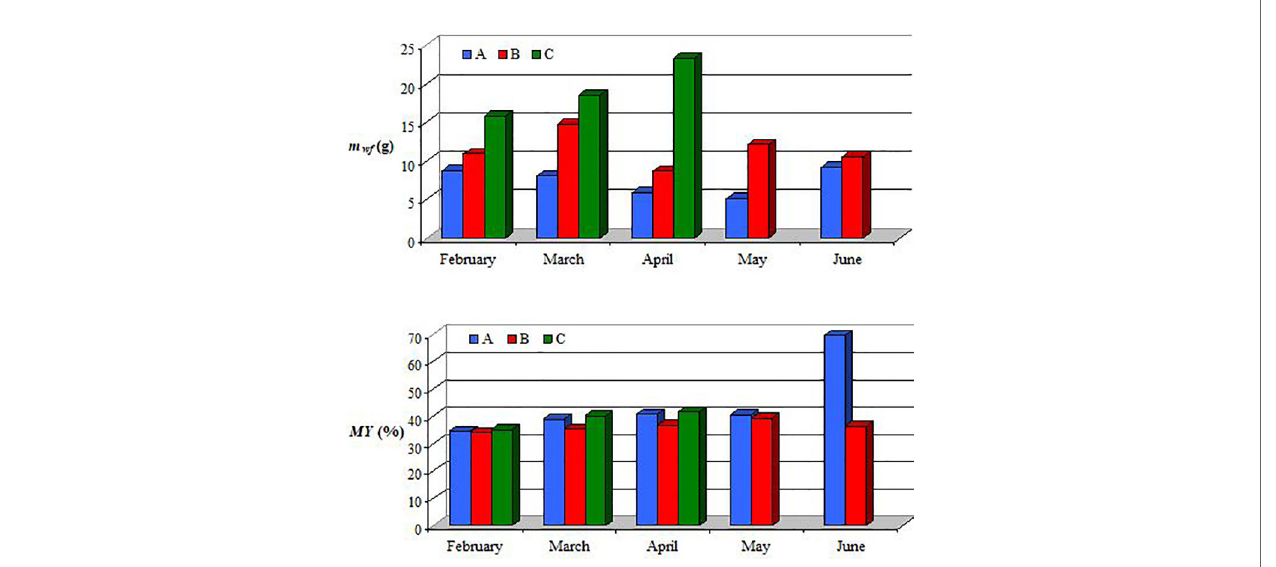
FIGURE 3 | Variation of wet fl esh mass ( m wf ) and meat yield ( MY ) in February − June 2019 for individuals from size classes A, B, and